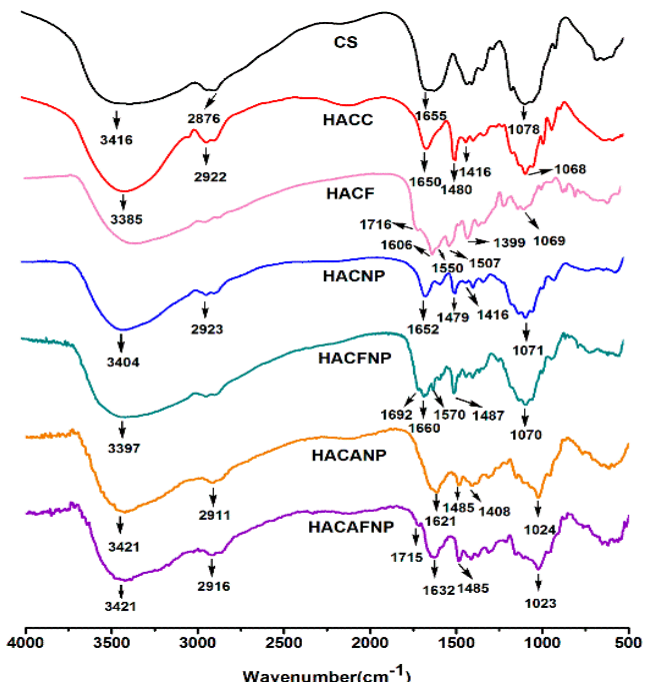
Figure 1. FTIR spectra of chitosan, chitosan derivatives, and chitosan nanoparticles. CS: chitosan, HACC: 2-hydroxypropyltrimethyl ammonium chloride chitosan, HACF: 2-hydroxypropyltrimethyl ammonium chloride chitosan grafting folic acid, HACNP: Nanoparticles based on 2-hydroxypropyltrimethyl ammonium chloride chitosan, HACFNP: Nanoparticles based on 2-hydroxypropyltrimethyl ammonium chloride chitosan grafting folic acid, HACANP: Nanoparticles loading ADM based on 2-hydroxypropyltrimethyl ammonium chloride chitosan, HACAFNP: Nanoparticles loading ADM based on 2-hydroxypropyltrimethyl ammonium chloride chitosan grafting folic